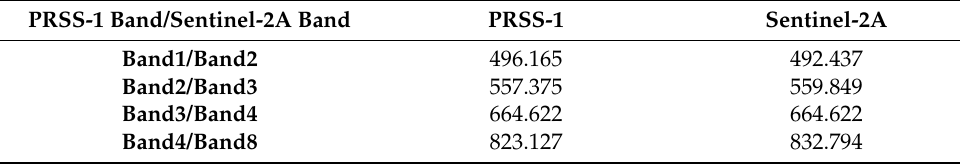
Table 2. PRSS-1 and Sentinel-2A band center wavelength (nm).